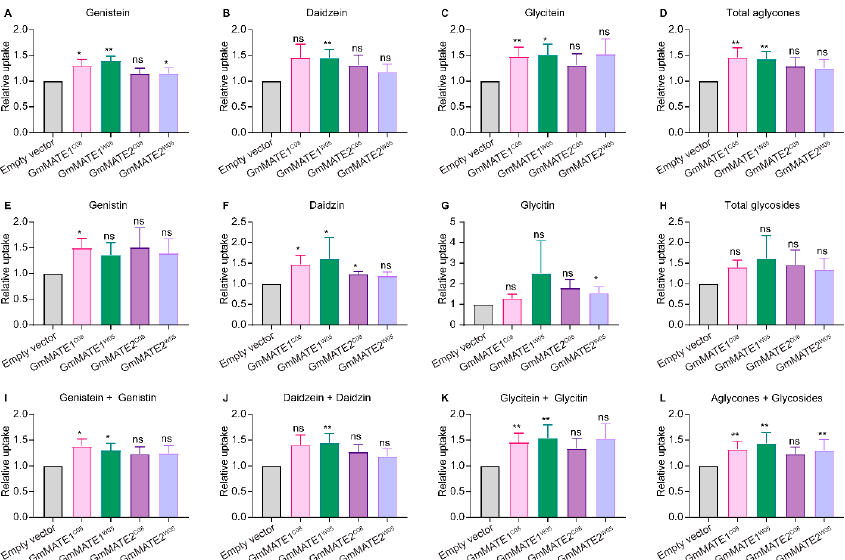
Figure 2. Yeast uptake assay with a mixture of genistin, daidzin, and glycitin. Metabolites were extracted from the yeast after feeding for 24 h and analyzed using UPLC against the respective standards. It appeared some of the glycosides were converted to aglycones in the yeast by endogenous enzymes. Values obtained from the yeast expressing GmMATEs were normalized to those from the empty vector control (EV) in the same experiment. The relative uptake levels of individual isoflavone species ( A – C,E – G ) and different isoflavone combinations ( D,H,I – L ) were determined. Total agly- cones ( D ) refers to the combination of genistein, daidzein, and glyciteins. Total glycosides ( H ) refers to the combination of genistin, daidzin, and glycitin. The relative uptake level of total aglycones and glycosides is shown in ( L ). Values shown are the mean of six independent experiments ± SEM. Sig- nificant differences compared to EV were determined by Mann-Whitney test. *, p < 0.05; **, p < 0.01; ns, not